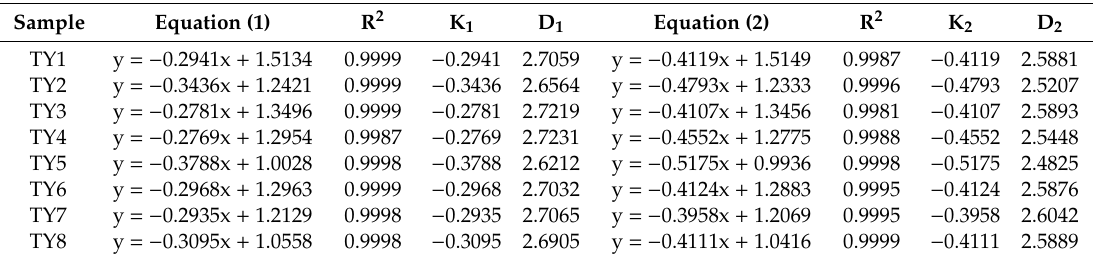
Figure 4. Fractal dimension results calculated from N 2 adsorption isotherms ( a ) and variation trend of fractal dimensions ( b ). Table 4. Fractal dimensions of marine shale samples calculated from the Frenkele–Halseye–Hill (FHH) model. R 2 : correlation coe ffi